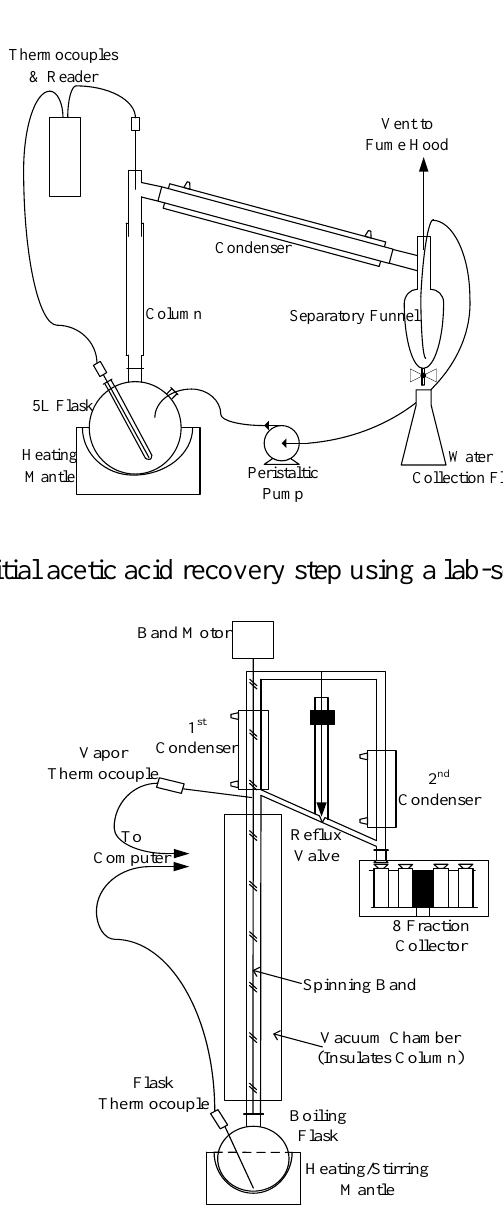
Figure 5. Diagram of the automated spinning band distillation system used for the second step in the acetic acid recovery